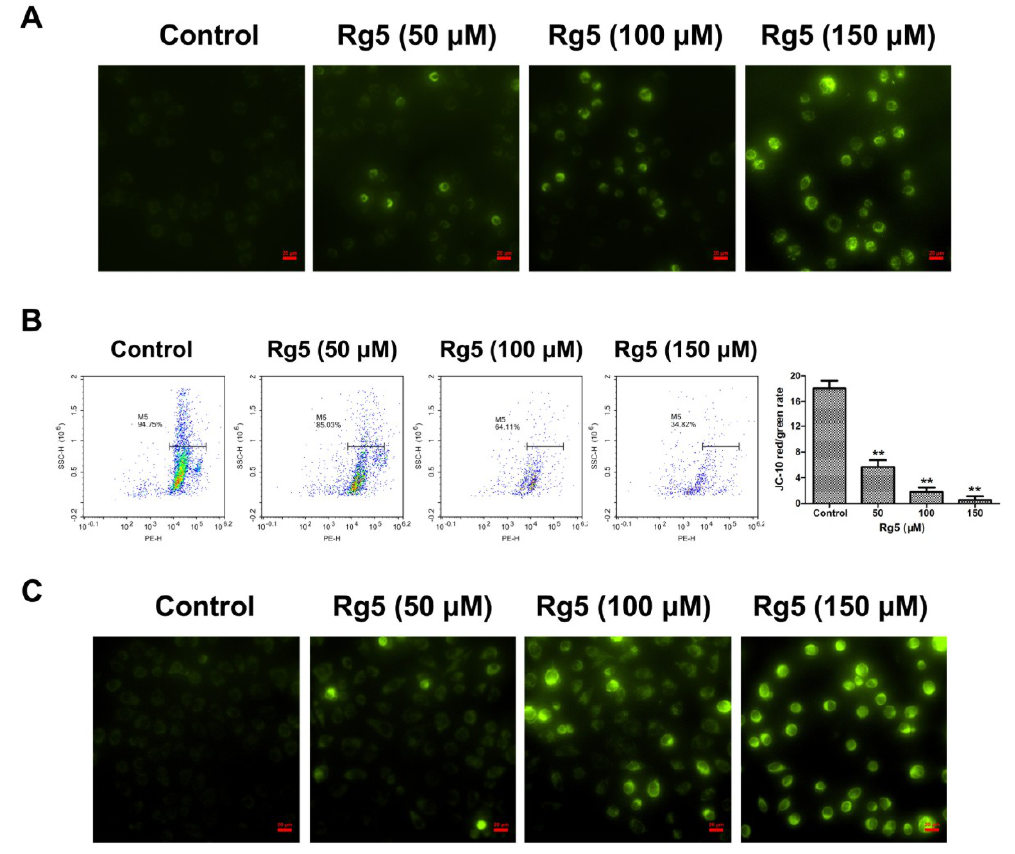
Figure 5. Rg5 induces apoptosis via mitochondria-mediated pathway. MCF-7 cells were exposed to Rg5 at various concentrations for 24 h. The mitochondrial membrane potential was analyzed with JC-10 staining using fluorescence microscopy ( A ) and flow cytometry ( B ). The histogram represents ratio of red / green fluorescence intensity. ( C ) The fluorescence images of MCF-7 cells after mitochondrial staining with MitoTracker Green. Scale bars = 20 μm. ** P < 0.01 as compared with the control.